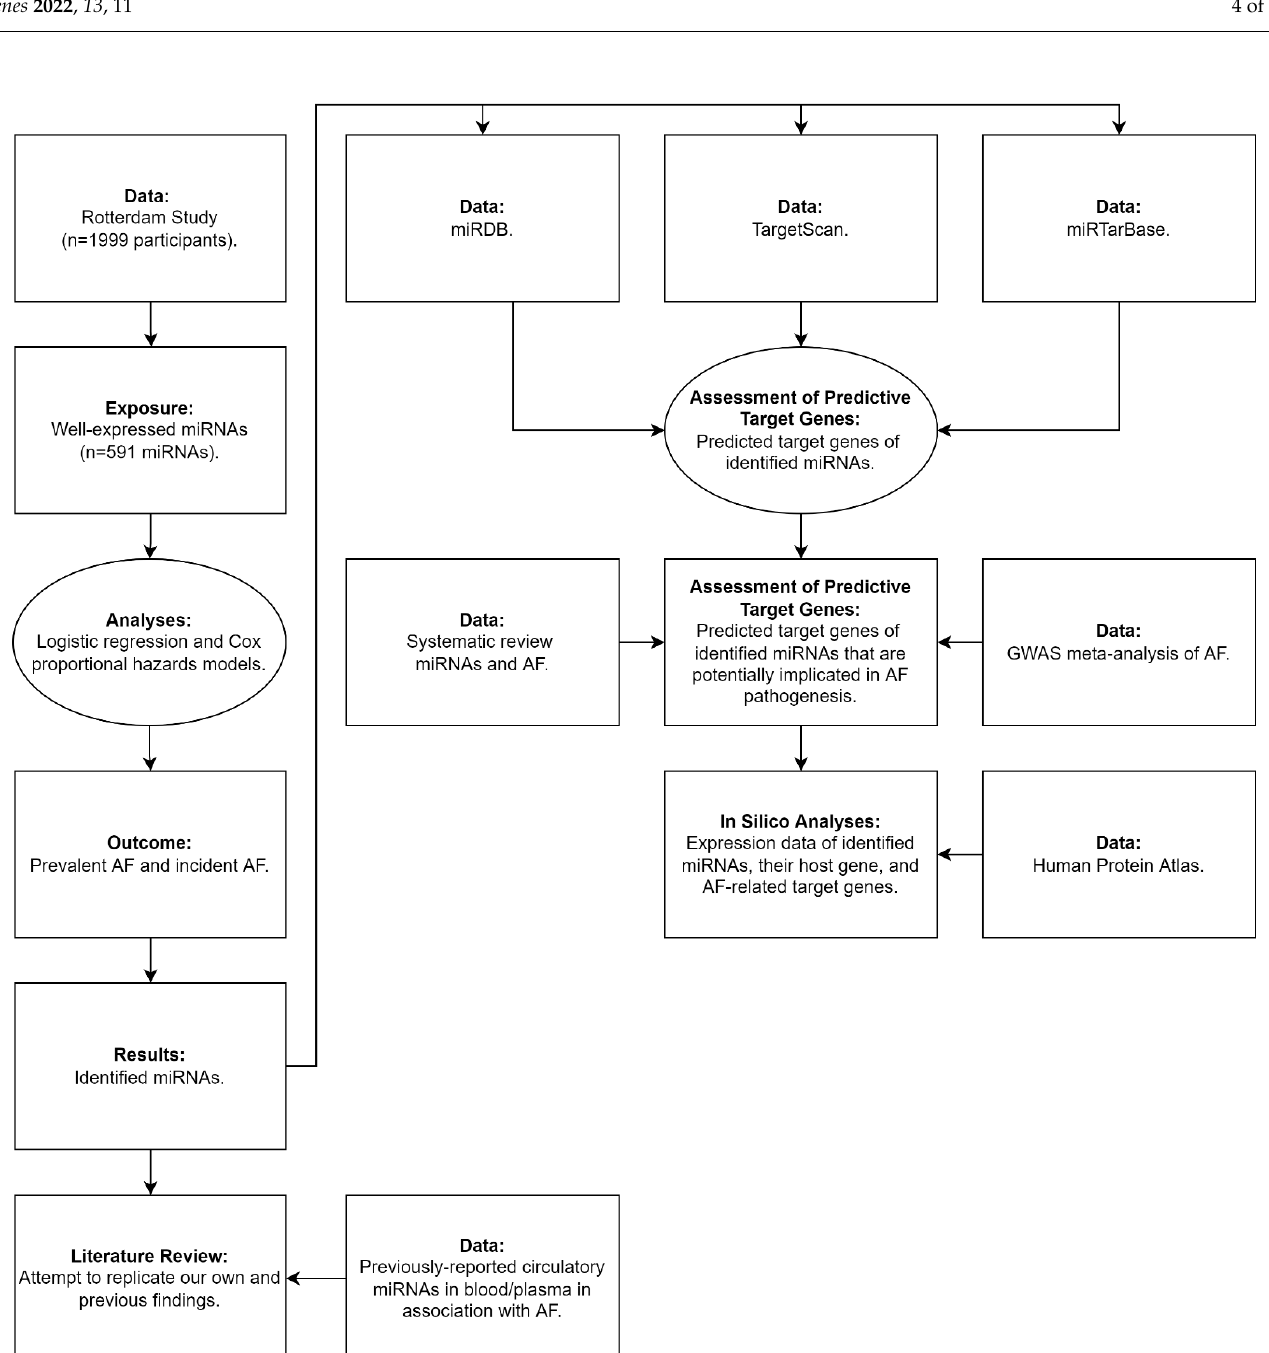
Figure 1. Flow chart for the conducted analyses and search strategy. Abbreviations: AF, atrial fibrillation; GWAS, genome-wide association study; miRNAs,